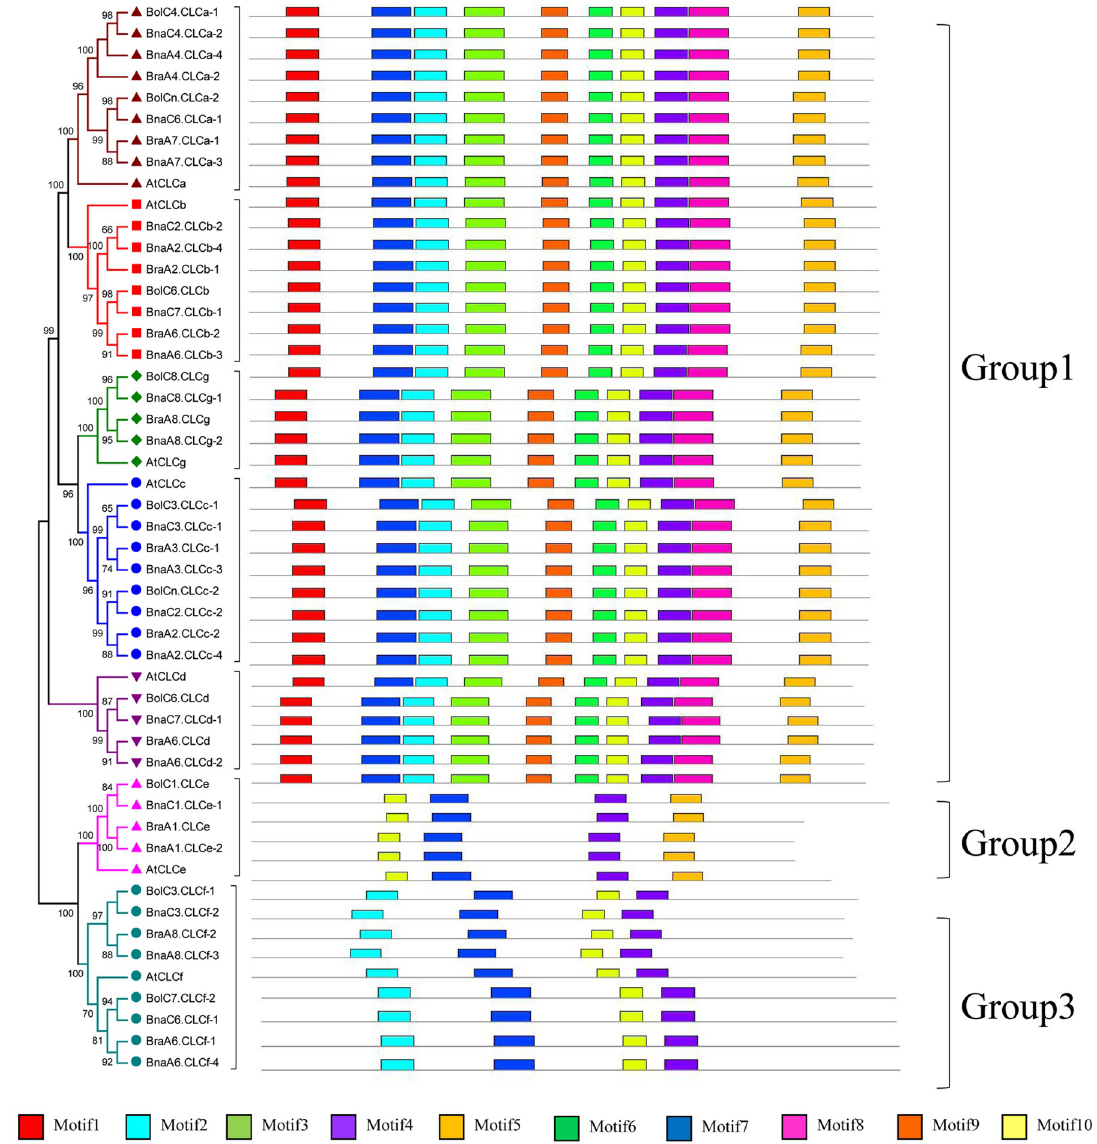
Fig 4. Characterization of the conserved motifs in the CLC proteins in A . thaliana and Brassica crops ( B . rapa , B . oleracea and B . napus ). Conserved motifs were predicted by the MEME program. The boxes with different color represent different conserved motifs, and the gray lines indicate non-detected motifs in the CLC family genes.